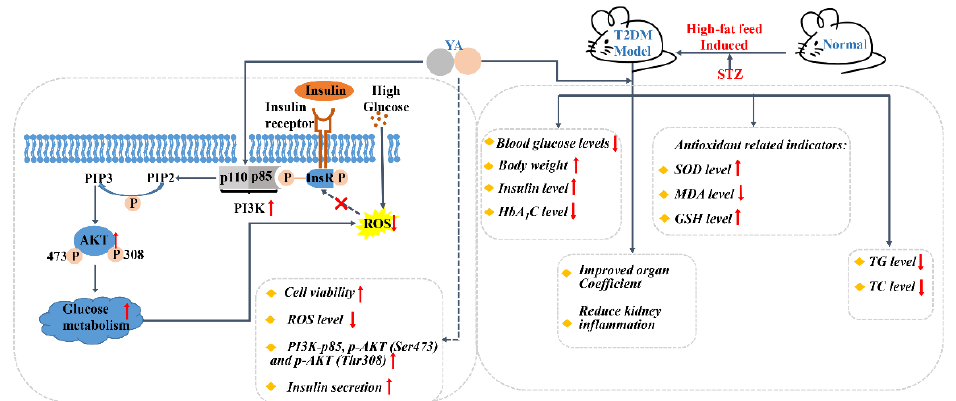
Figure 1. Schematic experiments of the YA effect on diabetes in vitro and in vivo. In cell assays, YA treatment increased cell viability and decreased intracellular ROS accumulation and increased insulin secretion in INS-1 cells exposed to H 2 O 2 , human amylin, or high glucose stimulation, which was achieved by activating the PI3K/AKT signaling pathway. In in vivo experiments, T2DM model was established by feeding a high-fat diet daily for 10 weeks and injecting STZ for 3 days in the fourth week. In T2DM mice, YA administration for 6 weeks improved the mice’s health, increased insulin secretion levels, and decreased blood sugar levels. It also increased the expression of antioxidant enzymes and decreased the levels of TG and TC. (ROS: reactive oxygen species; InsR: insulin receptor; PIP2: phosphatidylinositol 4, 5-bisphosphate; PIP3: phosphatidylinositol-3, 4, 5-triphosphate; AKT: protein kinase A; PI3K: Phosphatidylinositol 3-kinase; YA: Tyr-Ala; STZ: streptozocin).